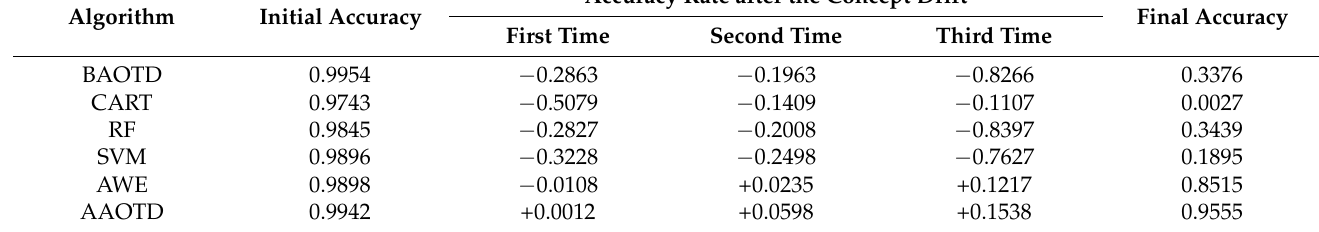
Table 3. The results of the 6 algorithms on the transformer in the Xinyu area: The initial accuracy, the change of accuracy in the 3 conceptual drifts (a positive number represents an increase in accuracy, a negative number represents a decrease in accuracy), and the final